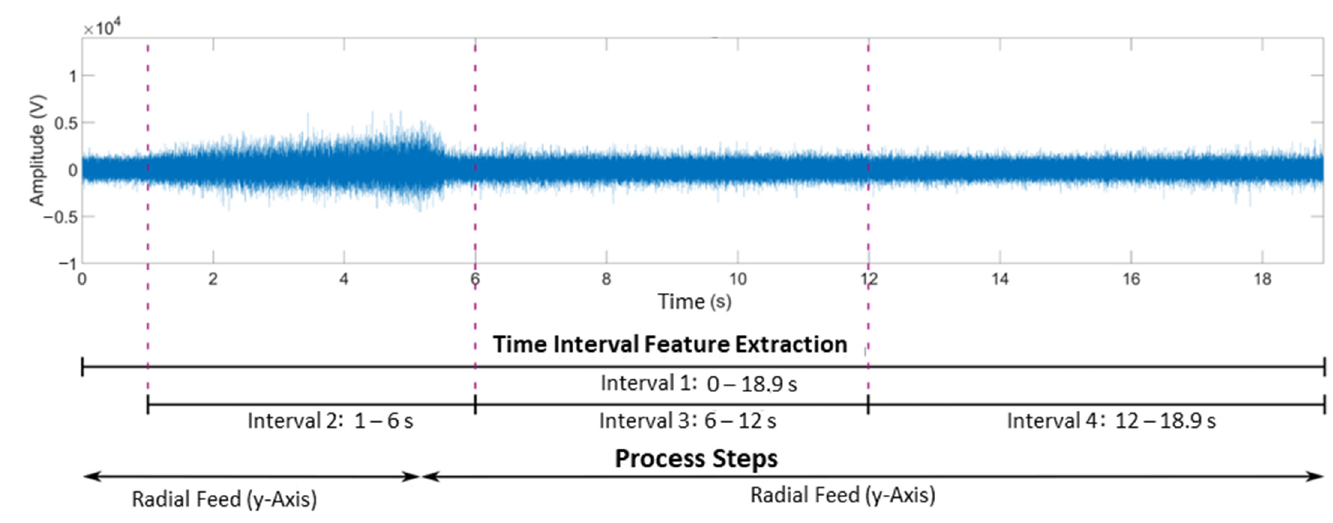
Figure 8. Raw signal with a tumble of 0 µ m and a radial feed of 0 mm as well as overview of the time intervals used and the process steps of the hobbing process.